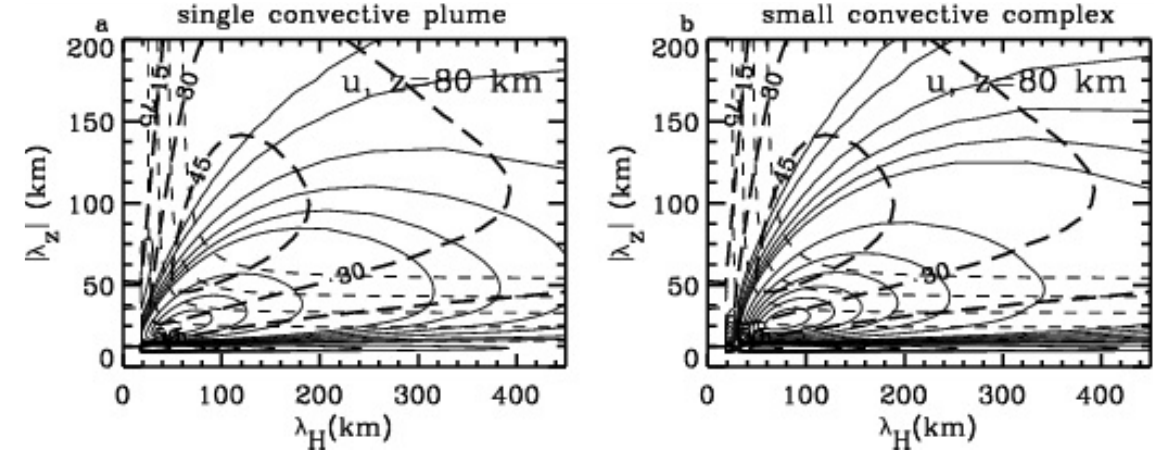
Fig. 2. 2-D distributions of maximum GW horizontal velocities at 80km from the convective GW source spectra for a single plume (left) and a 3-plume convective complex each having the same scales (right) inferred as a “best fit” for the GWs reverse ray traced by V08b. In each case, maximum inferred plume updrafts are 40ms − 1 . Solid contours are at 0.5, 1, 2, 3, 4, and 5ms − 1 , and then at 5ms − 1 intervals thereafter. Heavy dashed lines are vertical group velocities (in ms − 1 ) , and light dashed lines are horizontal phase speeds. We also note that amplitudes at the largest scales may be uncertain by ∼ 2 because of the discretization of the initial GW spectrum and the averaging over discrete responses required to define these distributions.